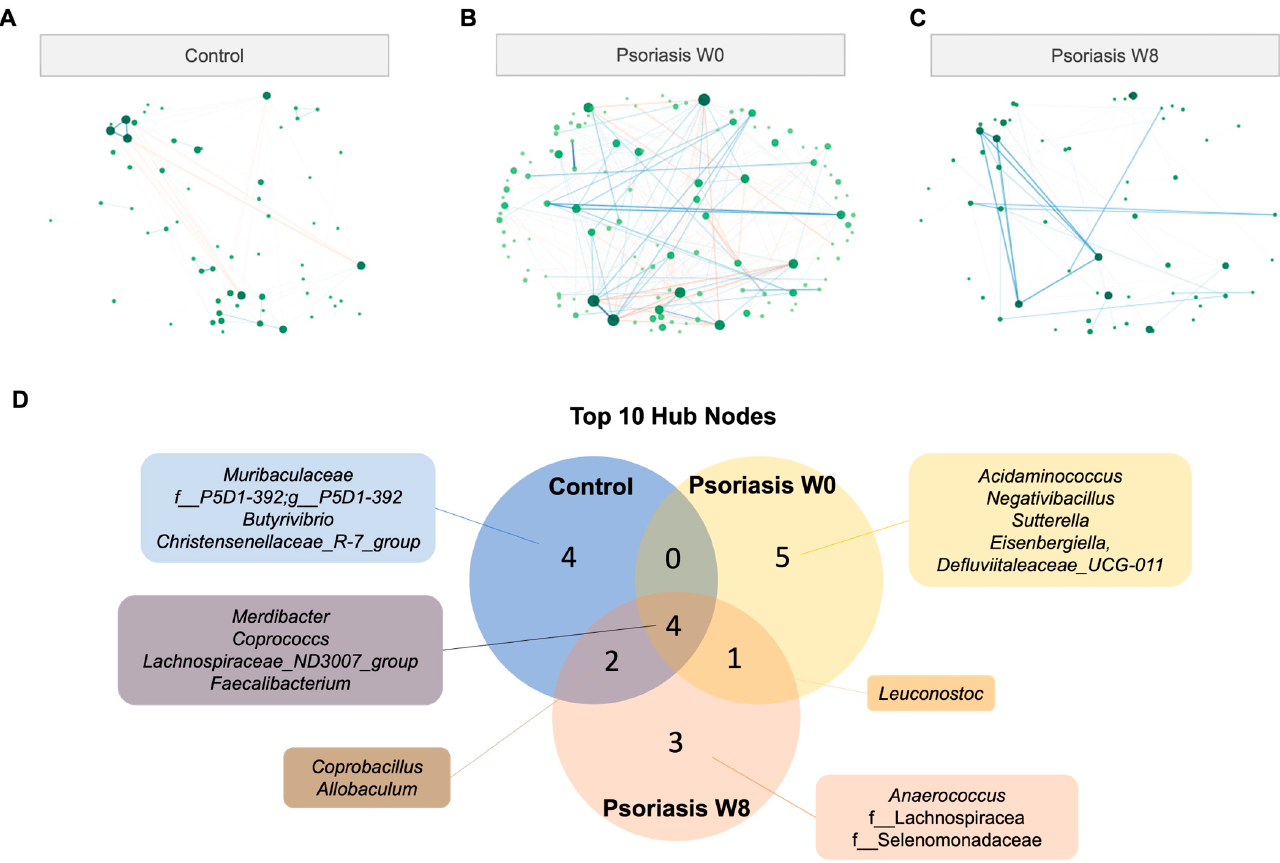
Figure 4C. It may hint at the potential functional mechanism of how probiotics alleviate disease severity in psoriasis patients.